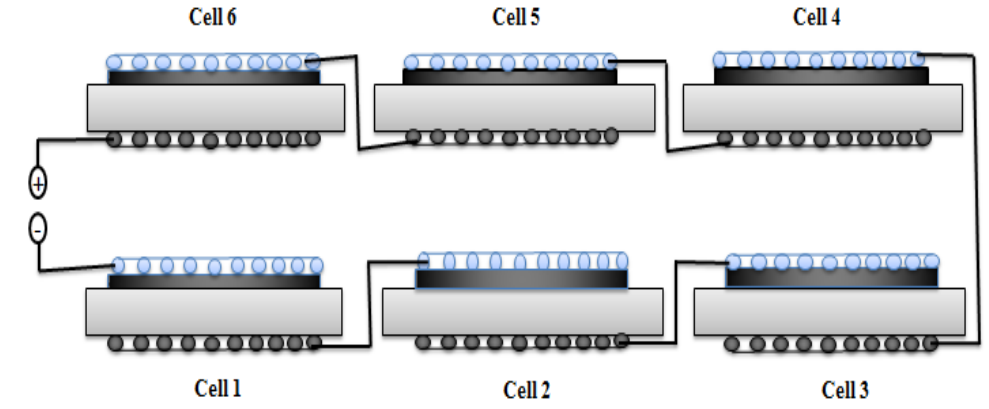
Figure 4. Schematic of interconnect construction of a 2D configuration SOFC stack.